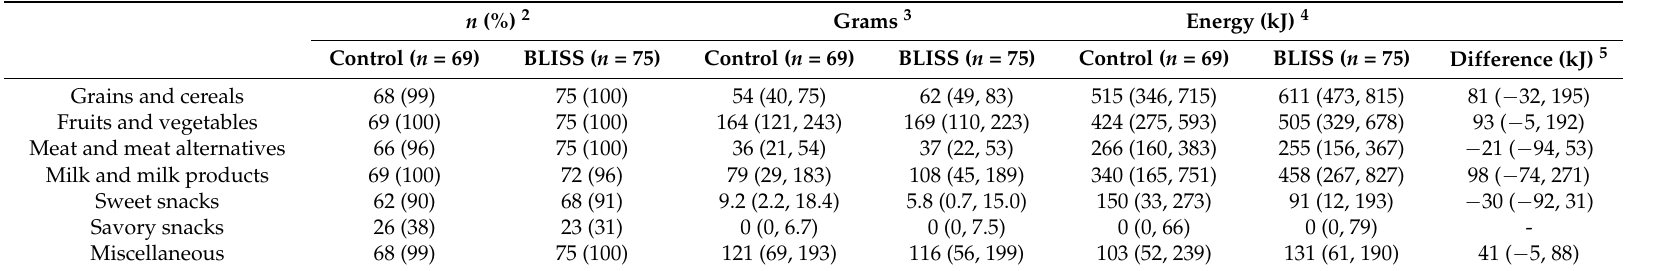
Table 7. Sources of energy (kJ) at 12 months of age from complementary foods alone, by food group.